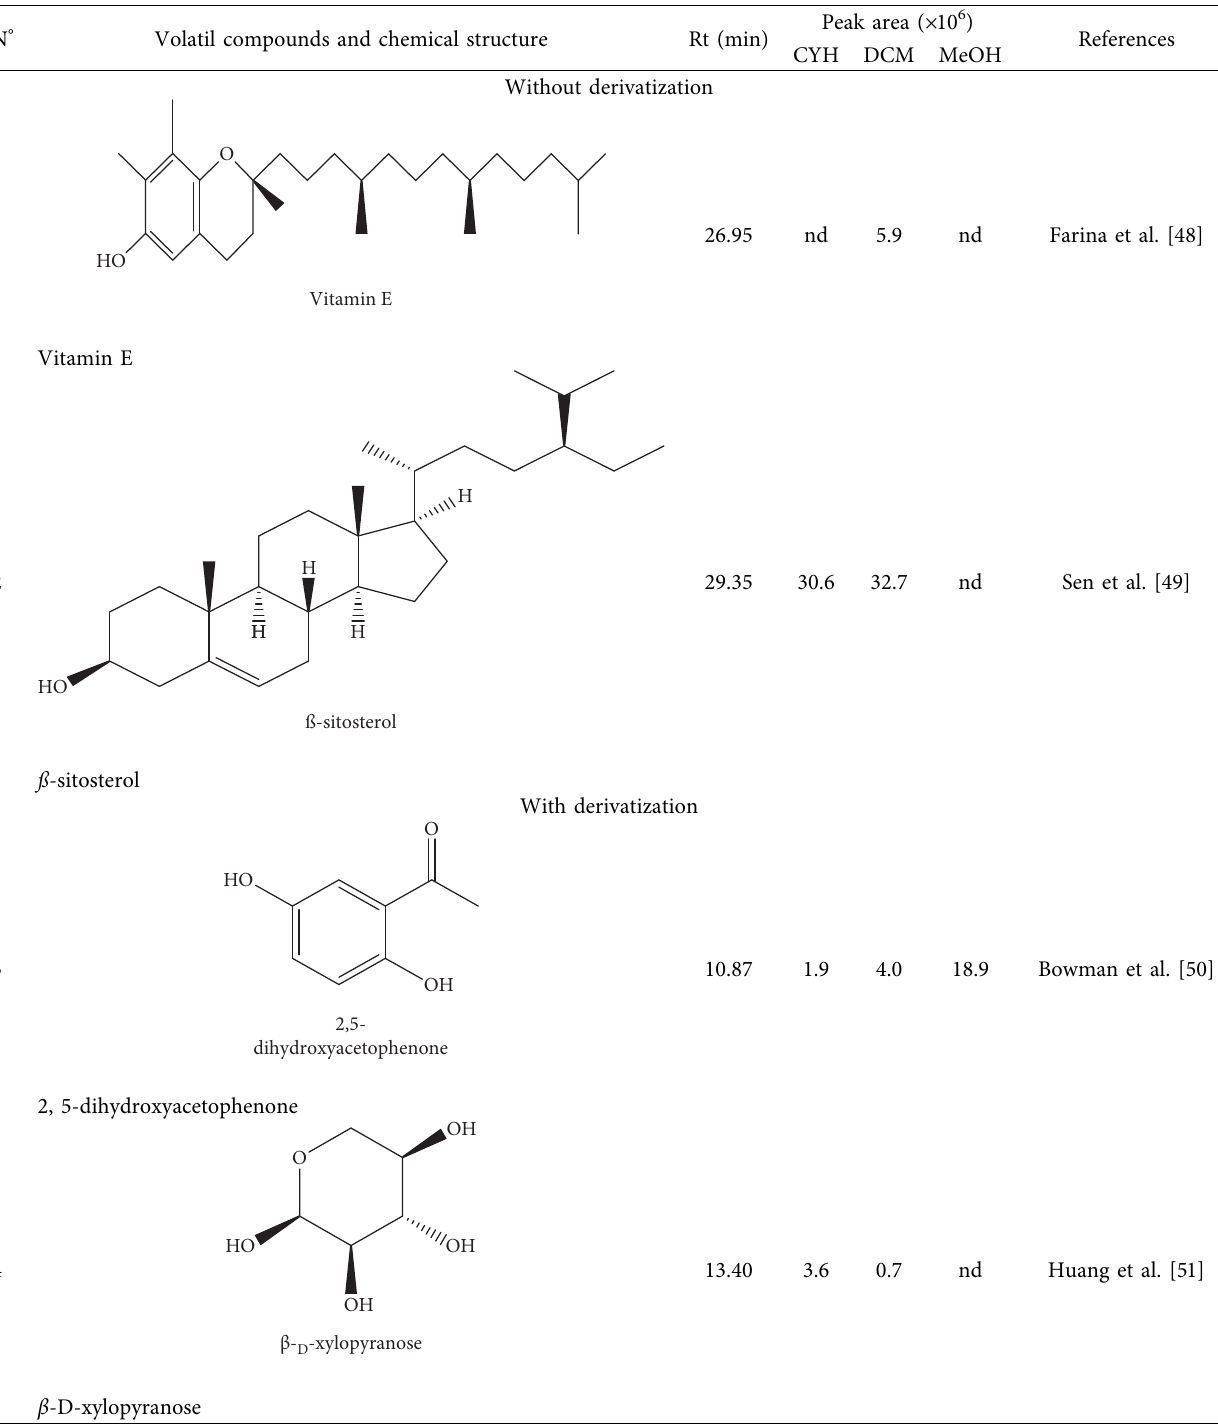
Table 4: Volatil compounds identified, by GC-MS, in the different extracts of R. crispus aerial